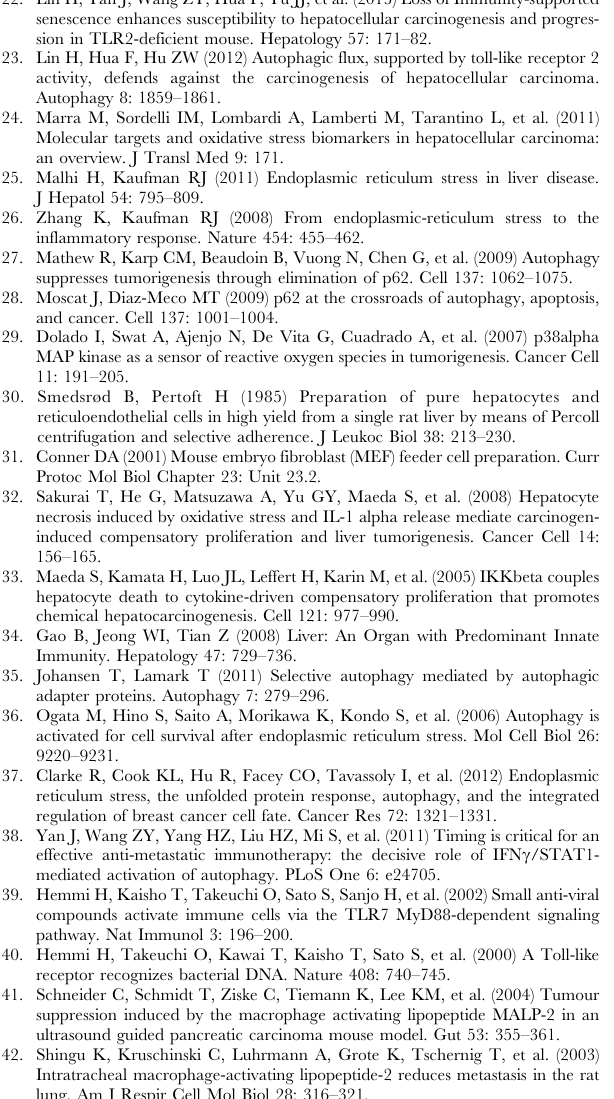
measured for ROS and p62 aggregates (middle panel). H 2 O 2 treatment induced more ROS and p62 aggregates in TLR2 2 / 2 parenchymal cells (n= 4, right panel). Figure S2 Expression of TLR2 associates negatively with ER stress in MEFs or HepG2 cells. (A) Expression of Bip, phospho-eIF2 a , eIF2 a , CHOP, IRE1 a , phospho-JNK1/2 and JNK1/2 was detected with Western blotting in MEFs treated with or without DEN (200 m g/ml for 24 h). Data are represen- tative immune blots (left panel) and mean 6 SEM (n= 4 per group, right panel). (B) The stable overexpression of TLR2 was